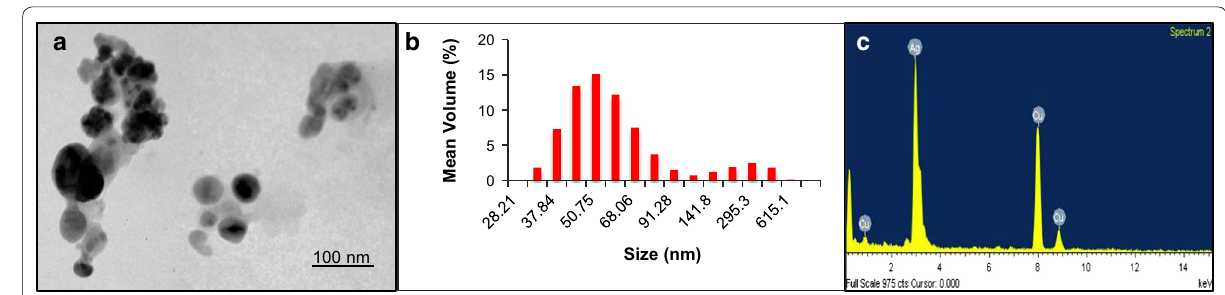
Fig. 5 Characterization of AgNPs synthesized by purified lignin peroxidase by a TEM, b particle size distribution, and c